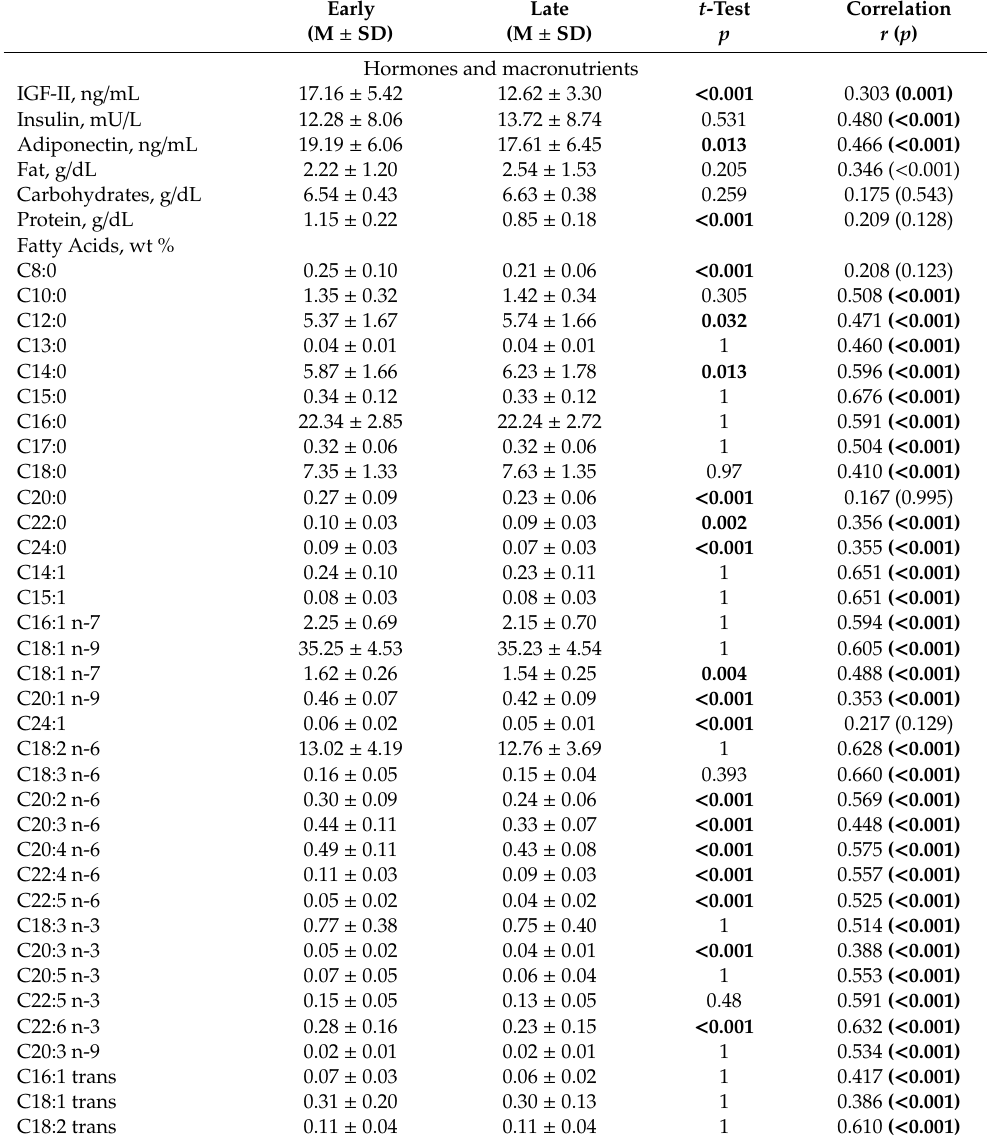
Table 7. Comparison of the concentrations measured in the early (from lactation day 16–100) and late samples (from lactation day 101–163) from the mothers who donated two samples ( n =